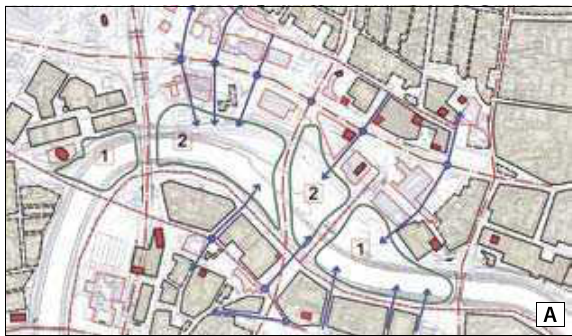
Fig. 2. Structural areas of the Green Framework (a, b